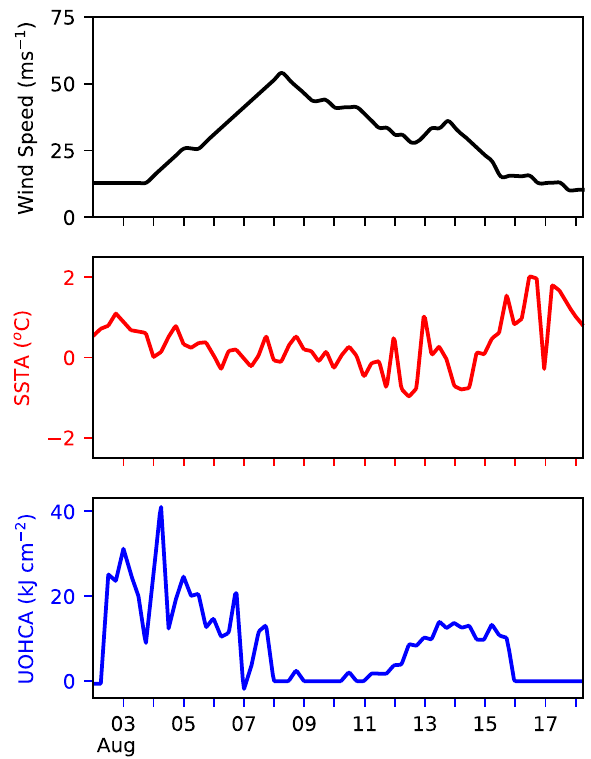
Figure 7. Along-track time series record for Hurricane Julio through ( Top ) maximum stustained wind speed with TC intensity category indicated, ( Center ) SST anomaly, and ( Bottom ) UOHC anomaly. Note: change in scale for SST anomaly (SSTA).